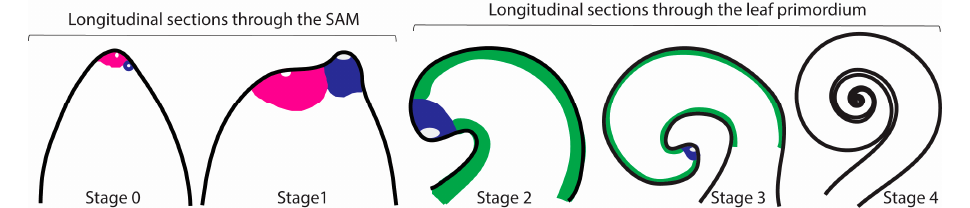
Figure 3. Stages of leaf development in the studied ferns and the meristems involved (pink = SAM, blue = LAM, green = MM). Stage 0 (leaf initiation) Leaf initiation begins with the enlargement of an epidermal cell close to the shoot apical meristem. Stage 1 (early leaf development): the leaf primordium is a protrusion that is more or less circular in outline; it has a prominent leaf apical initial (LAI). The LAI cuts off two files of cells that will become the marginal meristem (MM). Anatomically, the leaf apical meristem (LAM) resembles the shoot apical meristem (SAM). Stage 2 (middle leaf development): the apex of the leaf primordium is clearly curved with an apparent LAI and MM. Basipetal procambium development is apparent. Stage 3 (late leaf development): the apex of the leaf primordium apex is extremely curved towards the shoot apex owing to more cell divisions on the abaxial side. Stage 4 (late crosier formation; pinna emergence): the crosier is apparent and the LAI is the same size as the rest of the cells and no longer dominant; in divided leaves, acropetal development of pinnae is apparent (not shown). Different stages not to scale. White regions in the SAM and LAM indicate leaf apical initial/s.